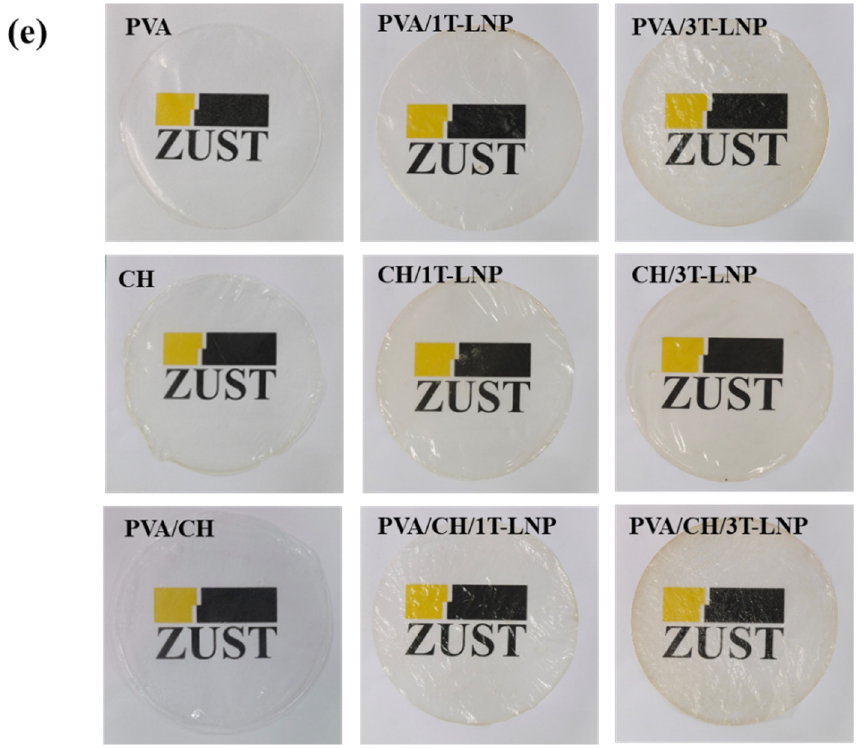
Figure 7. UV–vis spectra of ( a ) PVA, ( b ) CH, ( c ) PVA/CH based composite materials with different amount of LNP; ( d ) UV–vis spectra comparison of the binary and ternary composite films; ( e ) photo demonstration for transparency properties of films obtained from binary and ternary formulations. Table 4. Optical property comparison of prepared PVA, CH composite films with historical refer- ence.